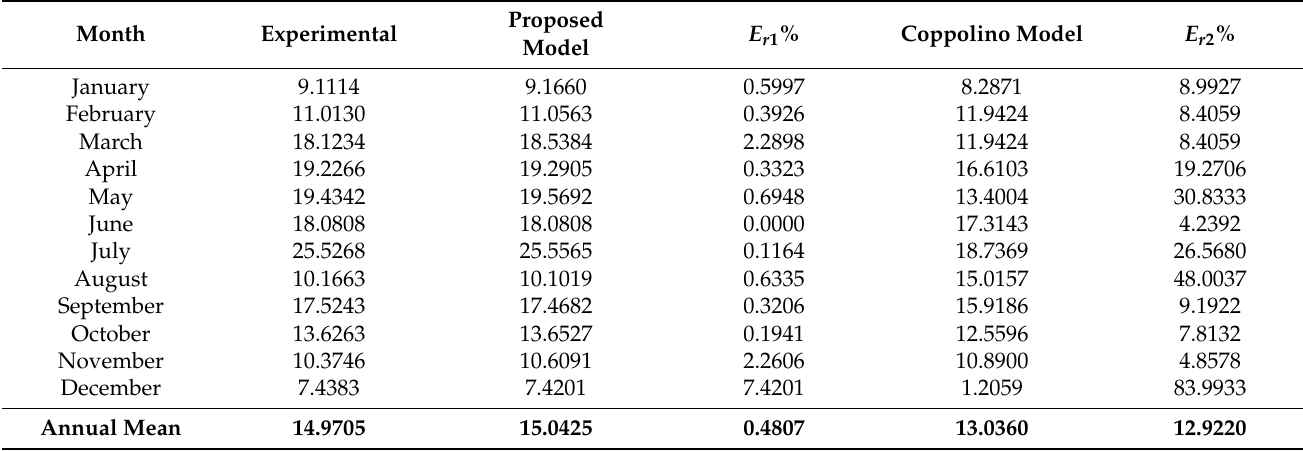
Figure 11. The comparison between the measured diffuse solar radiations and the diffuse solar radiation obtained by Capderou and R.Sun models for the site of Tlemcen. ( a ) 22 January 2006; ( b ) 8 April 2006; ( c ) 29 June 2006; ( d ) 26 September 2006. Table 6. The results for Senia site (MJ/m 2